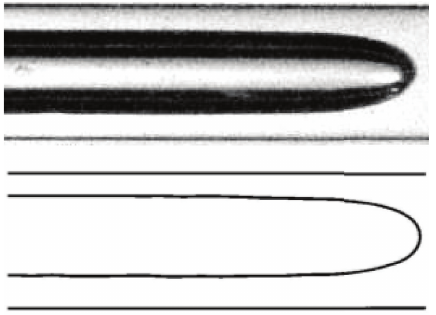
Figure 5: Bubble image before and after processing.